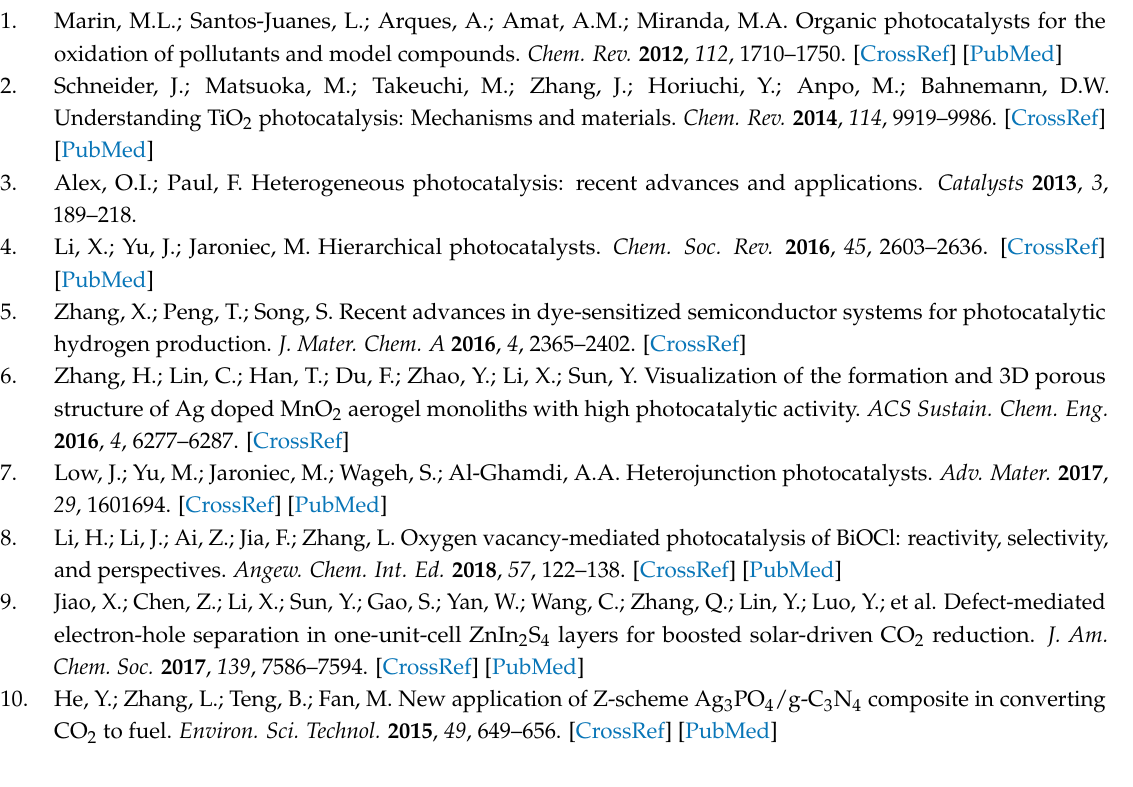
Figure S10: N 2 -adsorption-desorption isotherms of all the samples; Figure S11: photocurrent response spectra (a) and electrochemical impedance spectra (b) of all the samples; Figure S12: Trapping measurements and the corresponding rate constants for ciprofloxacin photodegradation over1BMO (a,b) and 6.7% P-1BMO (c,d); Figure S13: Trapping measurements and the corresponding rate constants for ciprofloxacin photodegradation over 3BMO (a,b) and 6.7% P-3BMO (c,d); Figure S14: Spectra of NBT transformation generated by 2BMO (a), P17-E (b) and 6.7% P-2BMO (c) under visible light irradiation. Table S1: Comparison of the photodegradation activity; Table